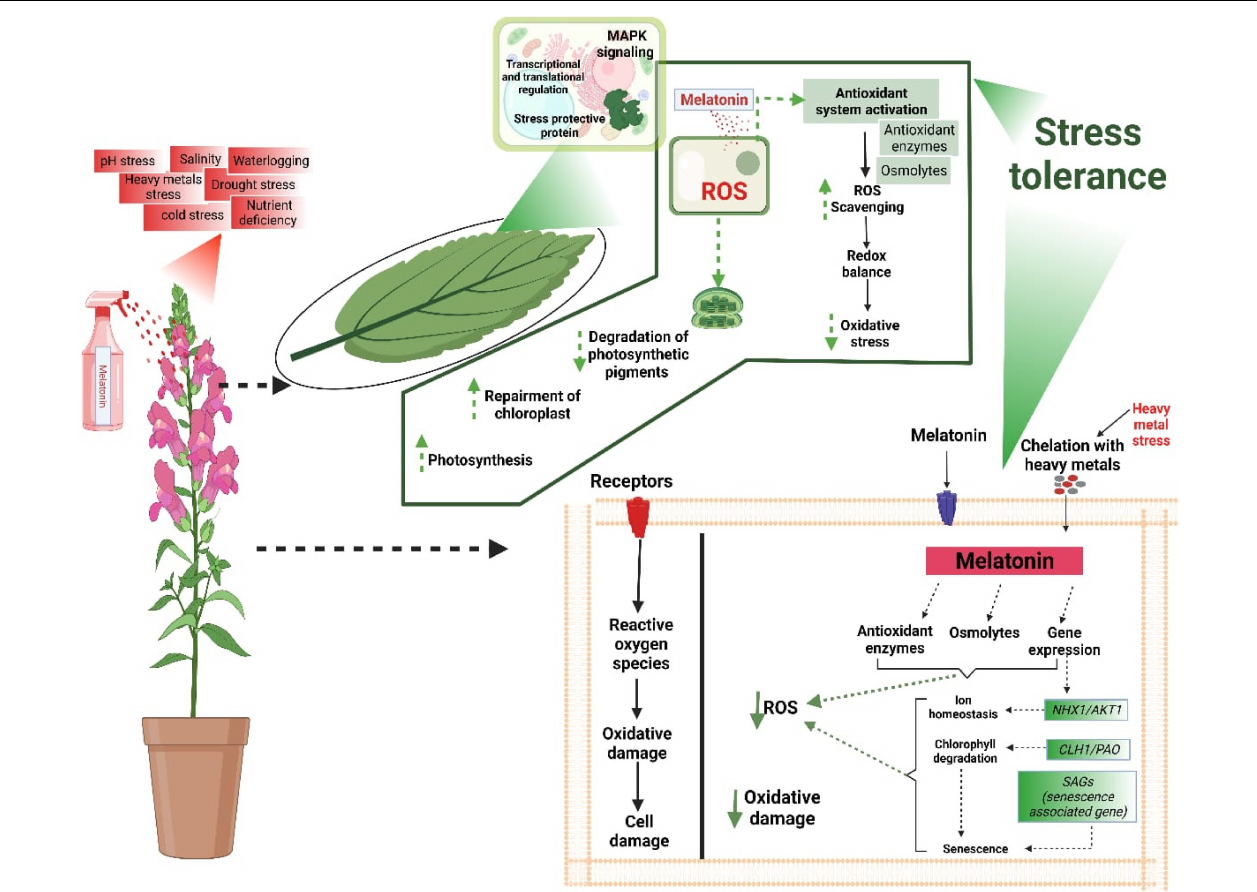
FIGURE 2 | MT being an amphiphilic molecule free crosses cellular membranes and directly scavenges the ROS by increasing the anti-oxidant activities. MT also improves osmolytes accumulation, protects photosynthetic apparatus, maintains redox balance, and affects the signalling transduction and genes expression linked with different stresses to induce stress